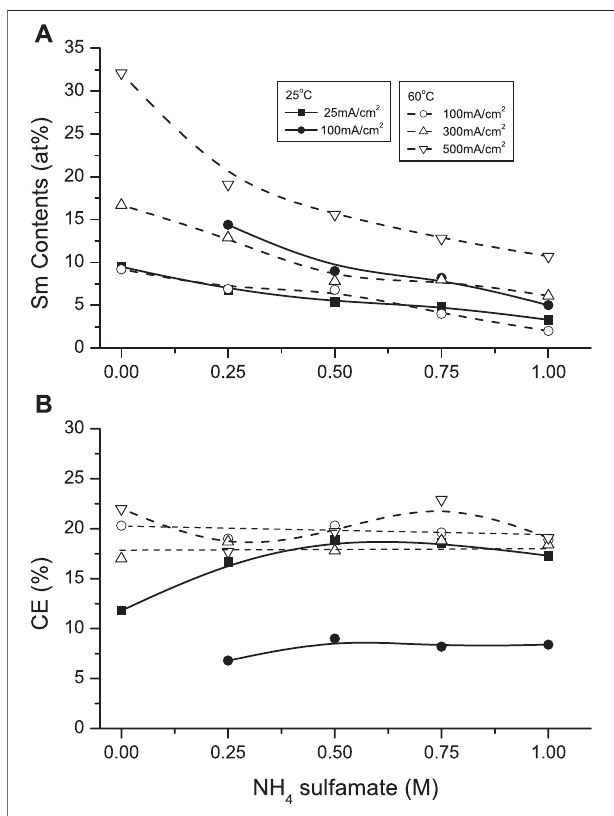
FIGURE 11 | Effect of NH 4 sulfamate concentration on (A) samarium deposit content and (B) current ef fi ciency at 25 and 60 ° C.